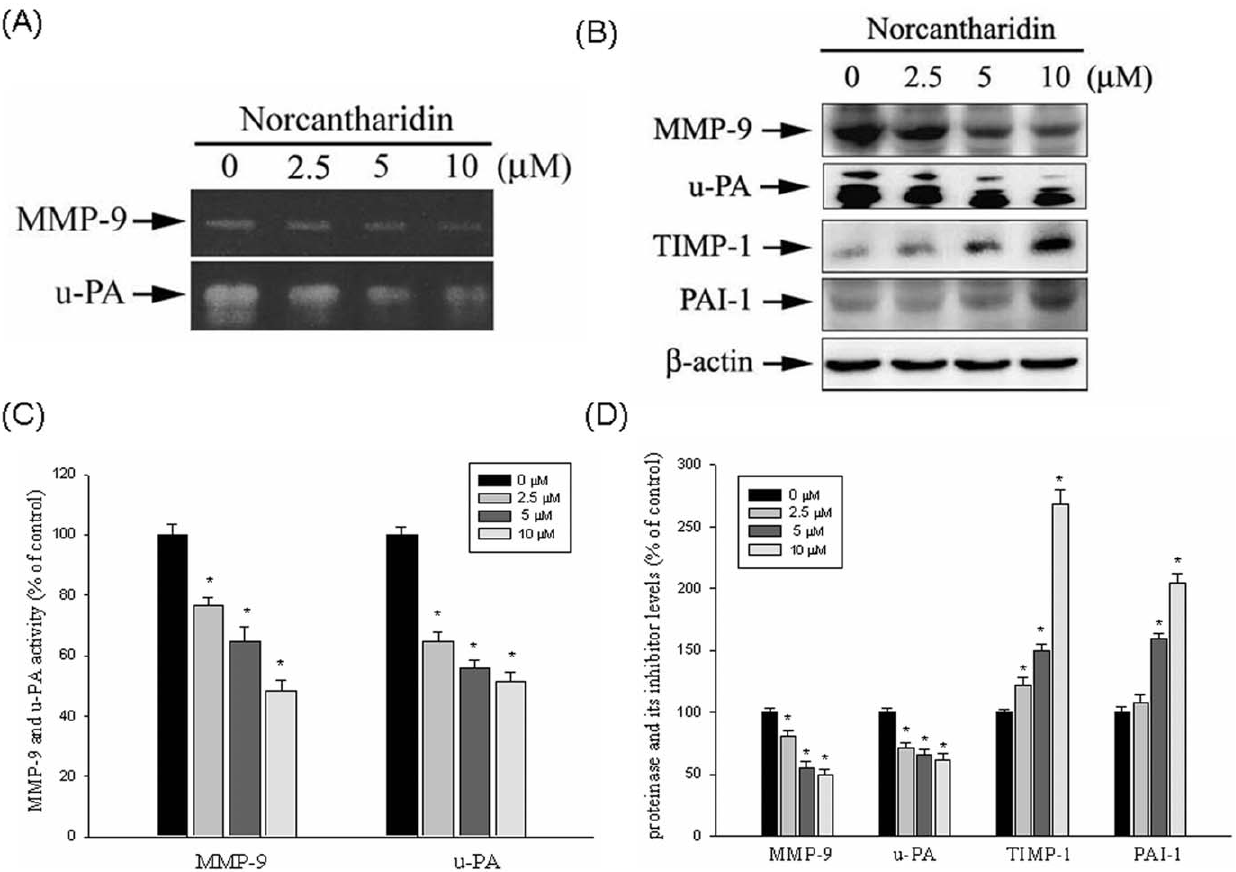
Figure 2. Effects of NCTD on the activity and protein level of MMP-9, u-PA and the protein level of the endogenous inhibitor TIMP-1 and PAI-1. (A) Huh7 cells were treated with NCTD (0, 2.5, 5 and 10 m M) for 24 h and then subjected to gelatin and casein zymography to analyze the activity of MMP-9 and u-PA respectively. (B) Huh7 cells were treated with NCTD (0, 2.5, 5 and 10 m M) for 24 h and then subjected to western blotting to analyze the protein levels of MMP-9, u-PA, PAI-1 and TIMP-1. (C&D) Quantitative results of MMP-9, u-PA, PAI-1 and TIMP-1 protein levels which were adjusted with b -actin protein level. The values represented the means 6 SD of at least three independent experiments. *P , 0.05 as compared with the vehicle